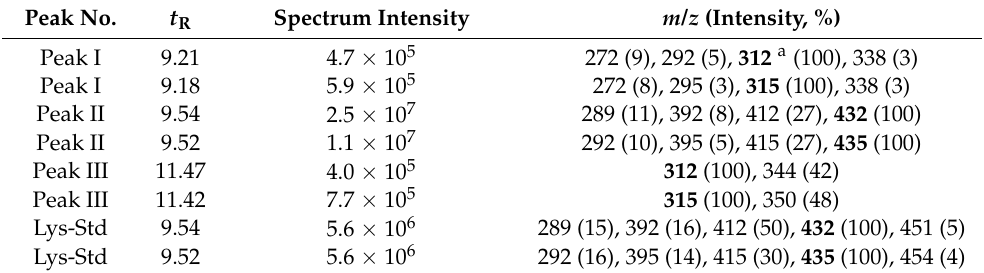
Table 2. GC-MS retention times ( t R , min) and most intense ions in the mass spectra of the three reaction products of homocitrulline derivatized with procedure B (PFPA/EA then 2 M HCl/CH 3 OH or 2 M HCl/CD 3 OD). For comparison, synthetic lysine standard (Lys-Std) was also derivatized with procedure B. See also Figure